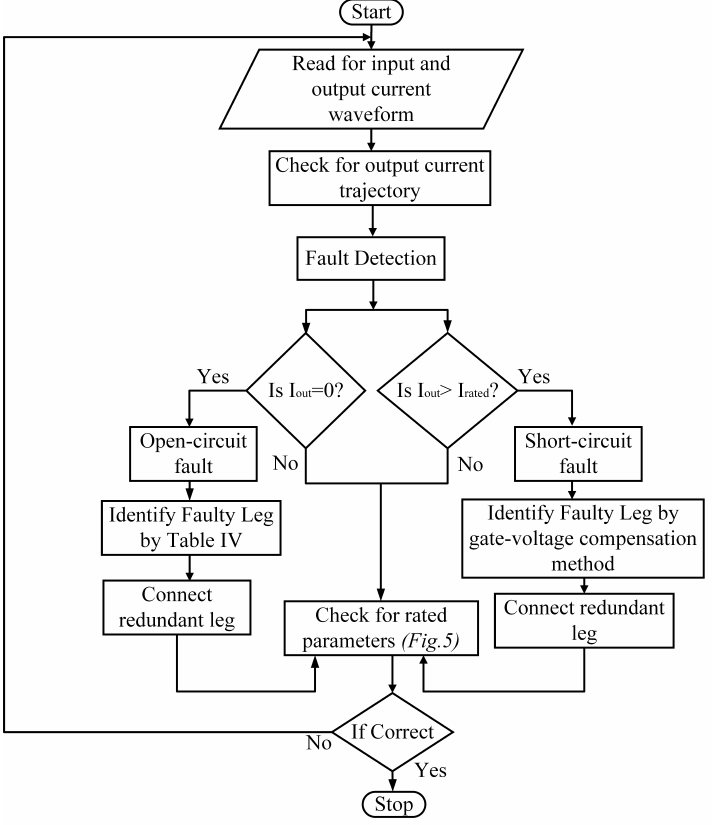
Figure 6. Flowchart of the proposed fault-tolerant